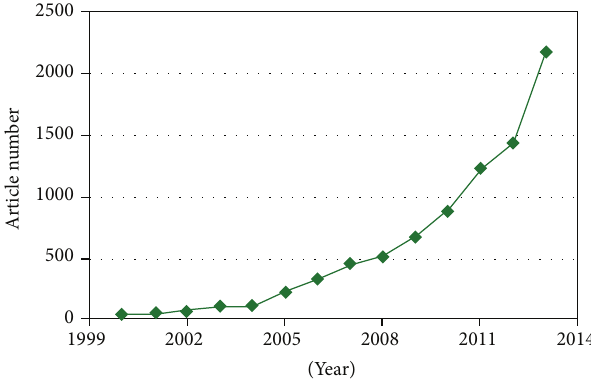
Figure 1: The increasing number of articles related to biomedical applications of magnetic nanoparticles based on Elsevier